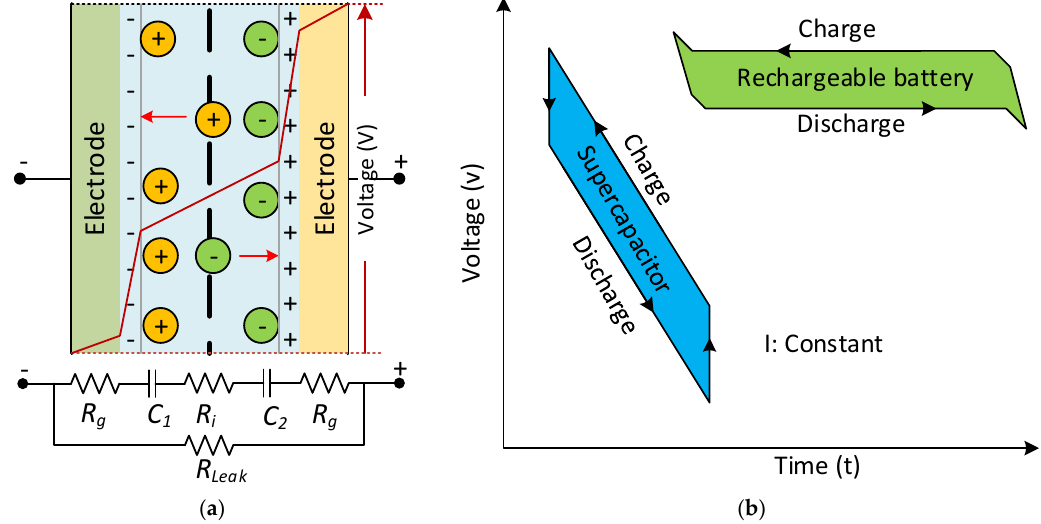
Figure 13. ( a ) The voltage distribution among the SC between simplified equivalent DC circuits. ( b ) Comparison of SC and battery voltage behaviour during the charge and discharge time.